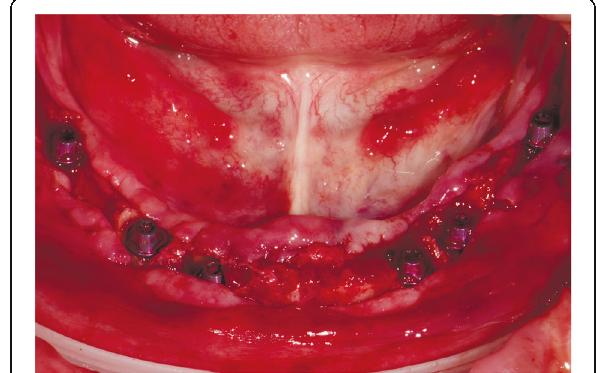
Fig. 10 Implant osteotomies performed through a surgical template